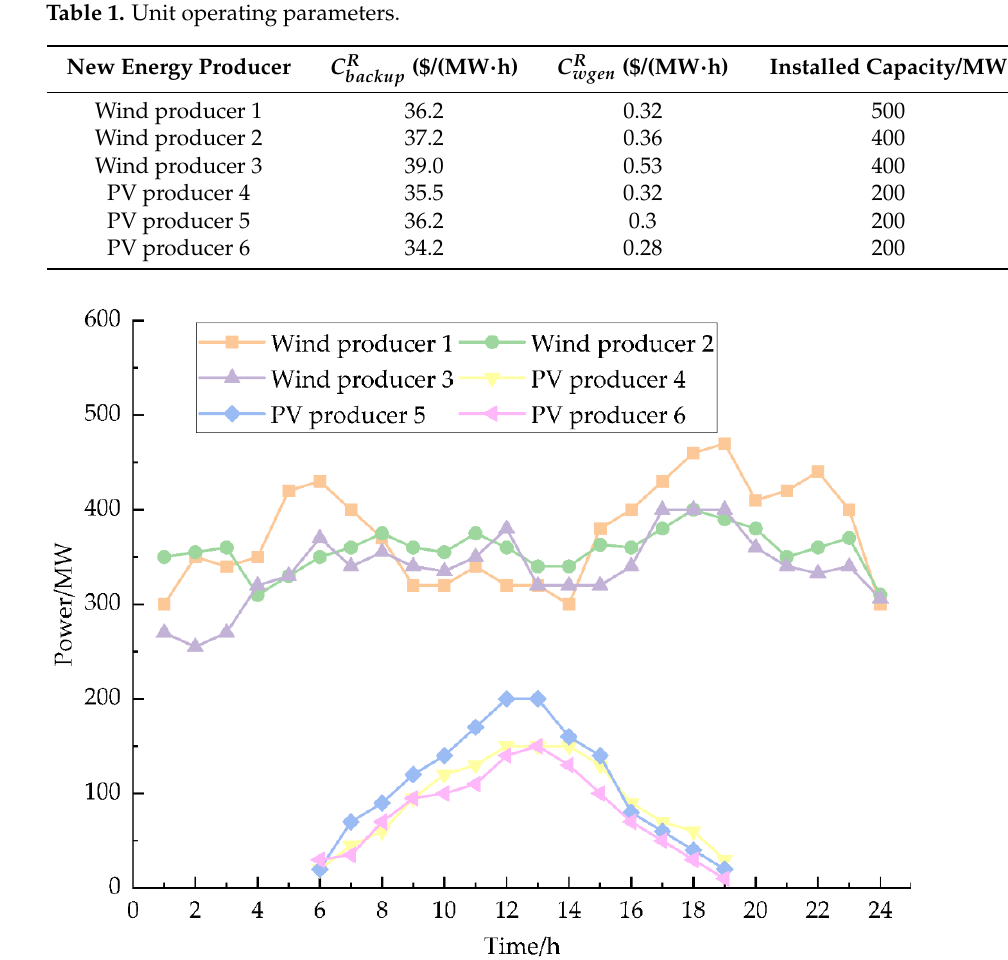
Figure 4. Output forecast value of renewable energy producers.